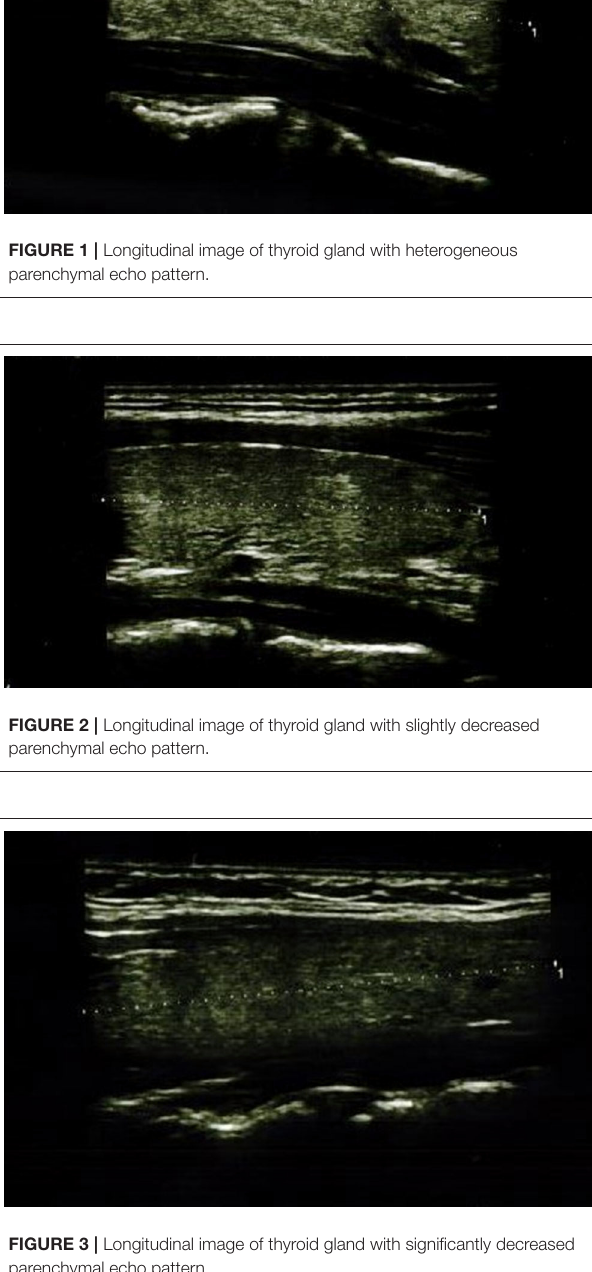
contrary, fT4 levels were significantly higher in the control group than those in the IFX patients. No differences in fT3 levels between the two groups were found. All patients, in both groups, were negative for thyroid autoantibodies (ATPO, aTG).